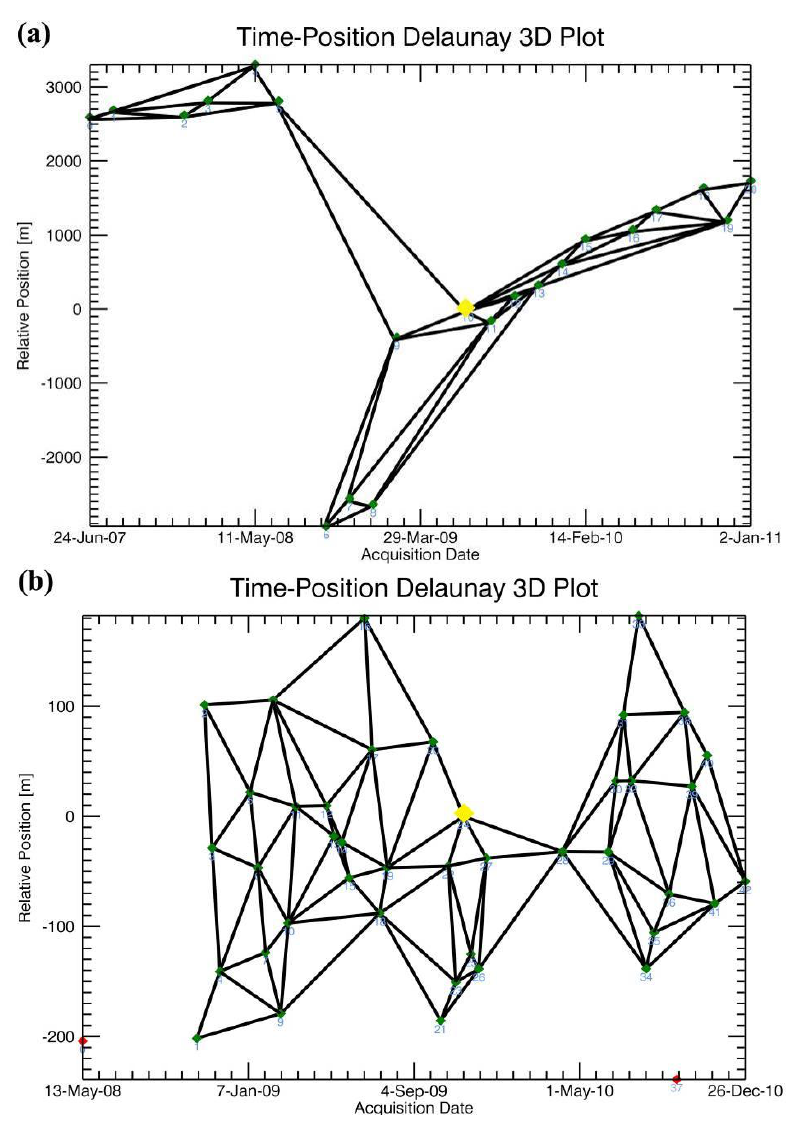
Figure 3. Estimated Delauney network of interferograms in spatial and temporal domain, ( a ) ALOS PALSAR; ( b ) TerraSAR. The yellow point indicates the reference imagery for temporal image co-registration; and red points in (b) indicate two TerraSAR images discarded due to the spatial baseline threshold (150